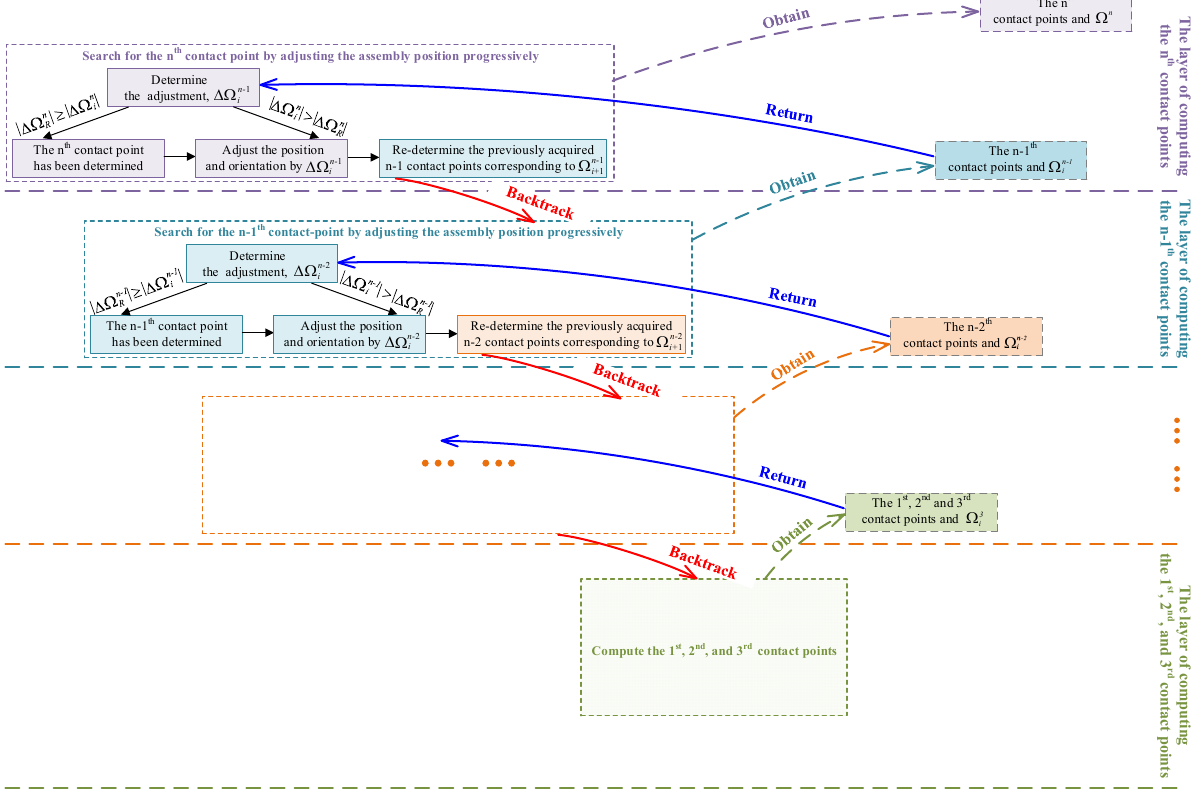
Figure 6. Principle of the recursion of contact points.